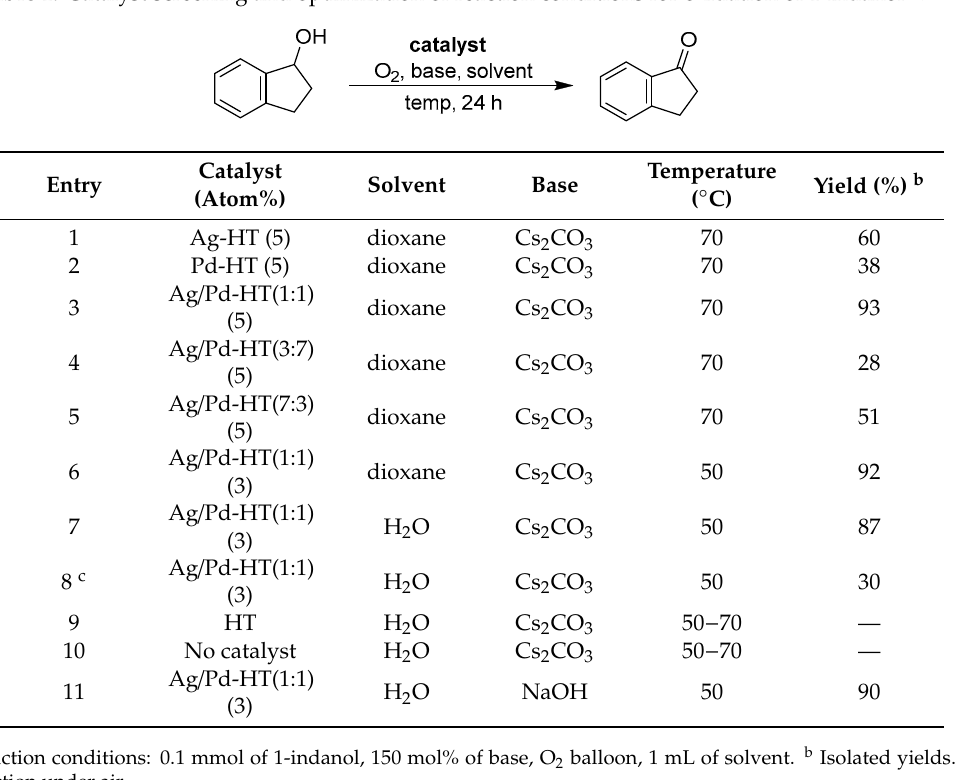
Table 1. Catalyst screening and optimization of reaction conditions for oxidation of 1-indanol a .